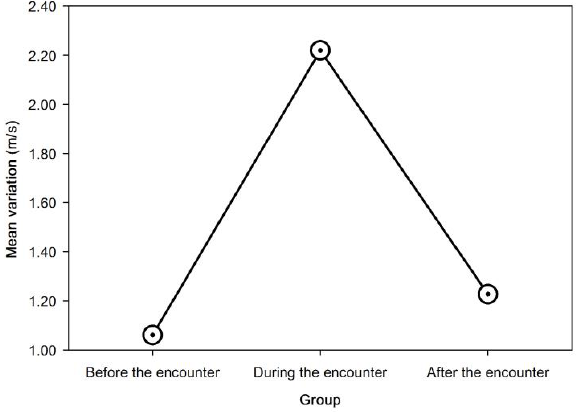
Figure 9. A box plot diagram showing the changes in TC intensity during the stages before, during, and after TC interactions with warm ocean eddies.